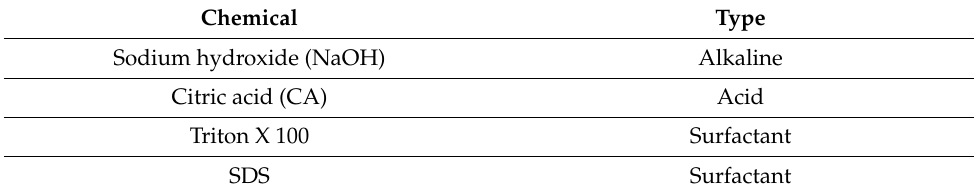
Table 2. Types of cleaning